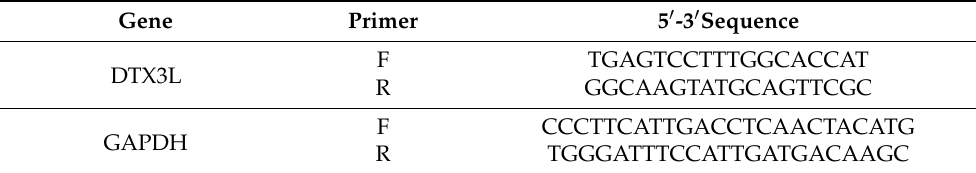
Table 1. Sequences of primer pairs used for RT-PCR. Gene